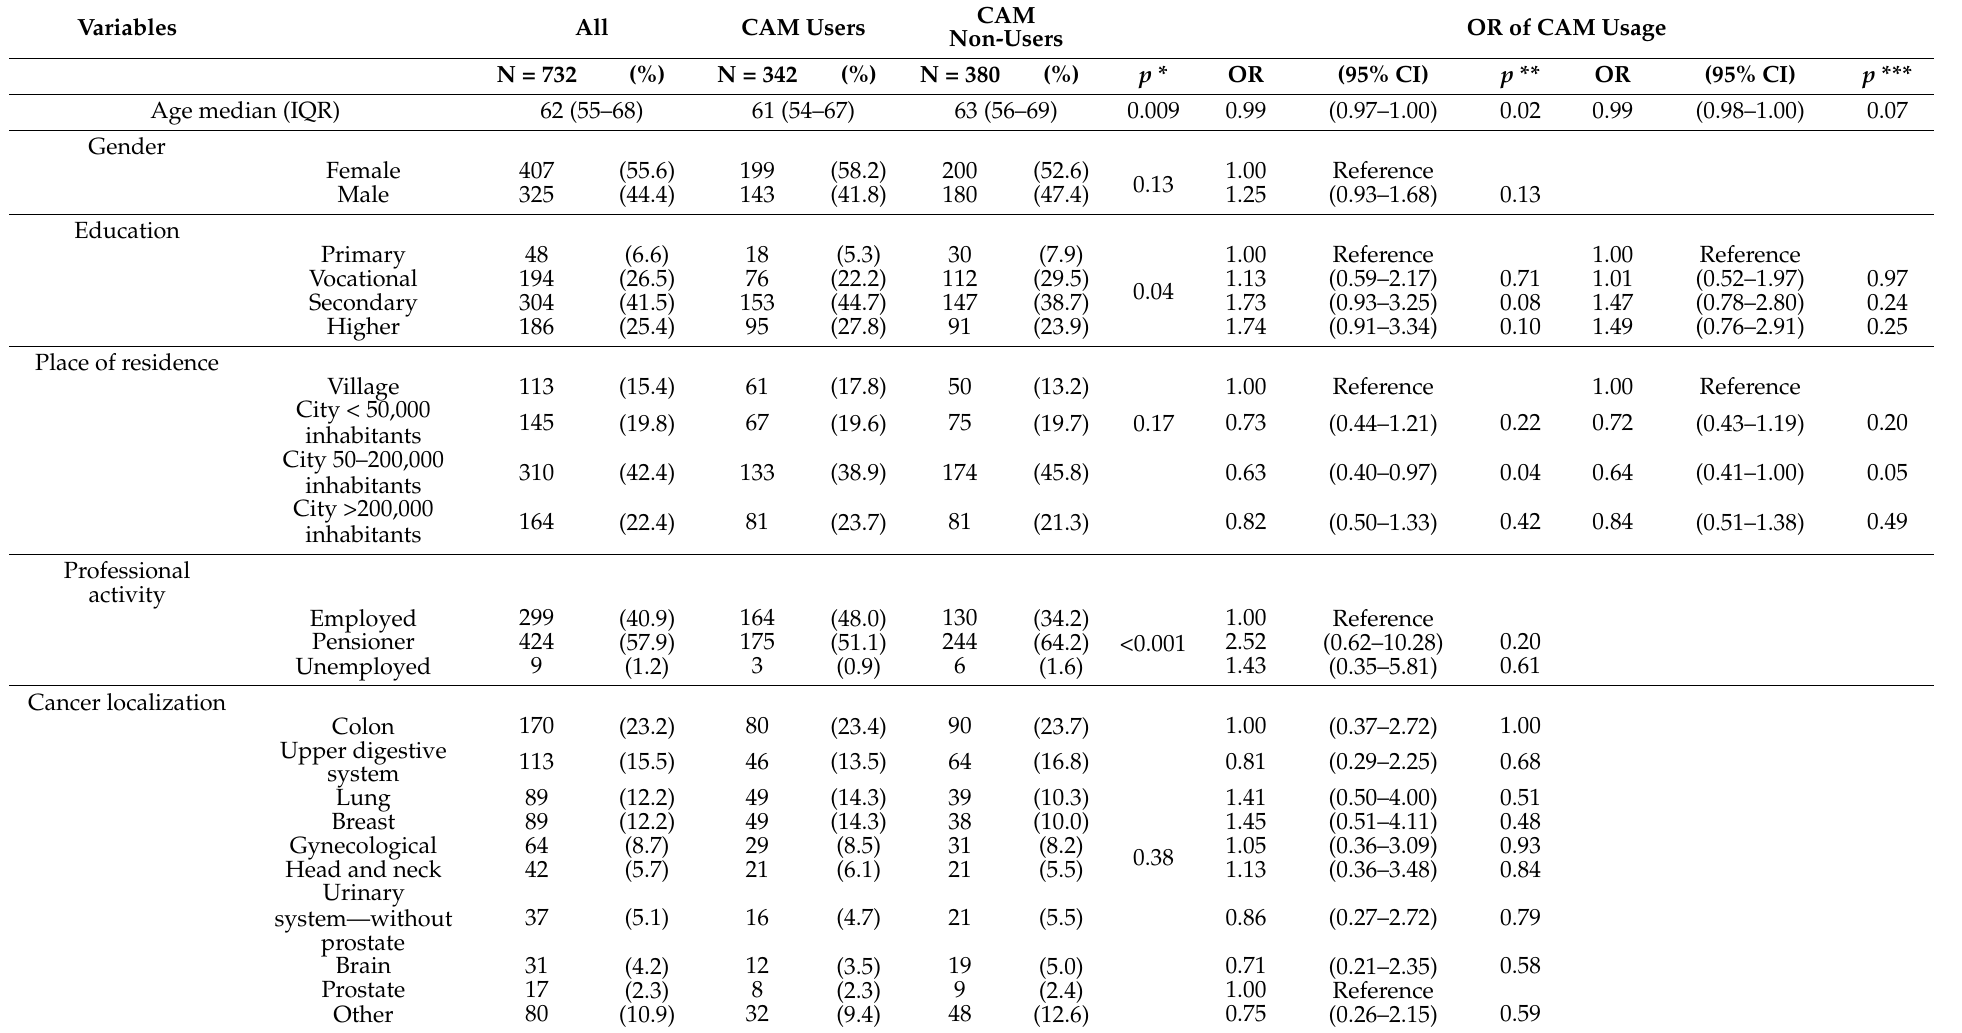
Table 1. Characteristics of patients and odds ratio (OR) of CAM usage due to various